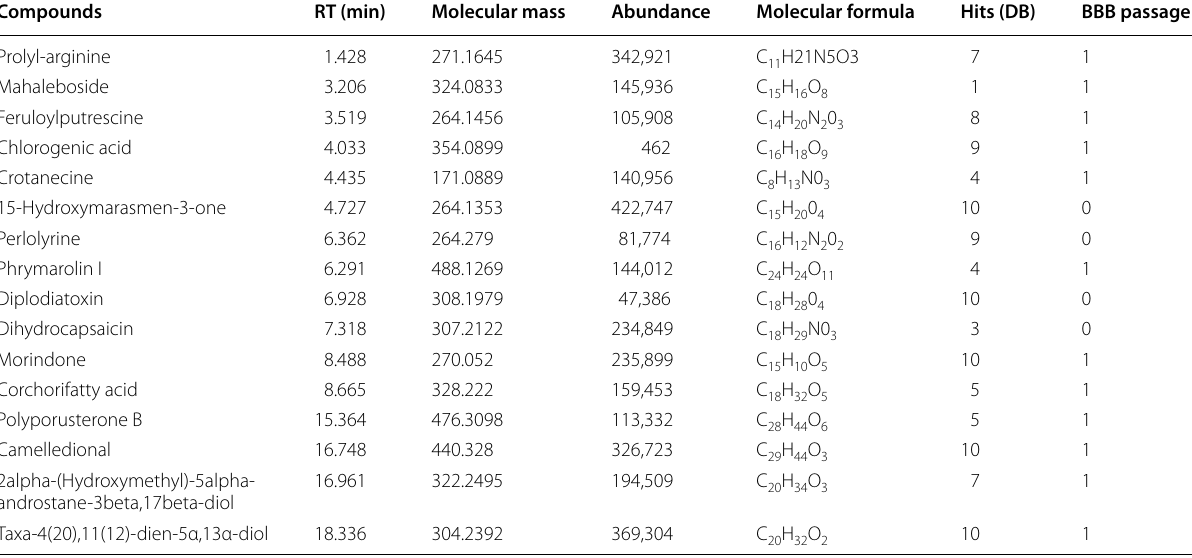
Table 4 Identification of constituents by LCMS analysis